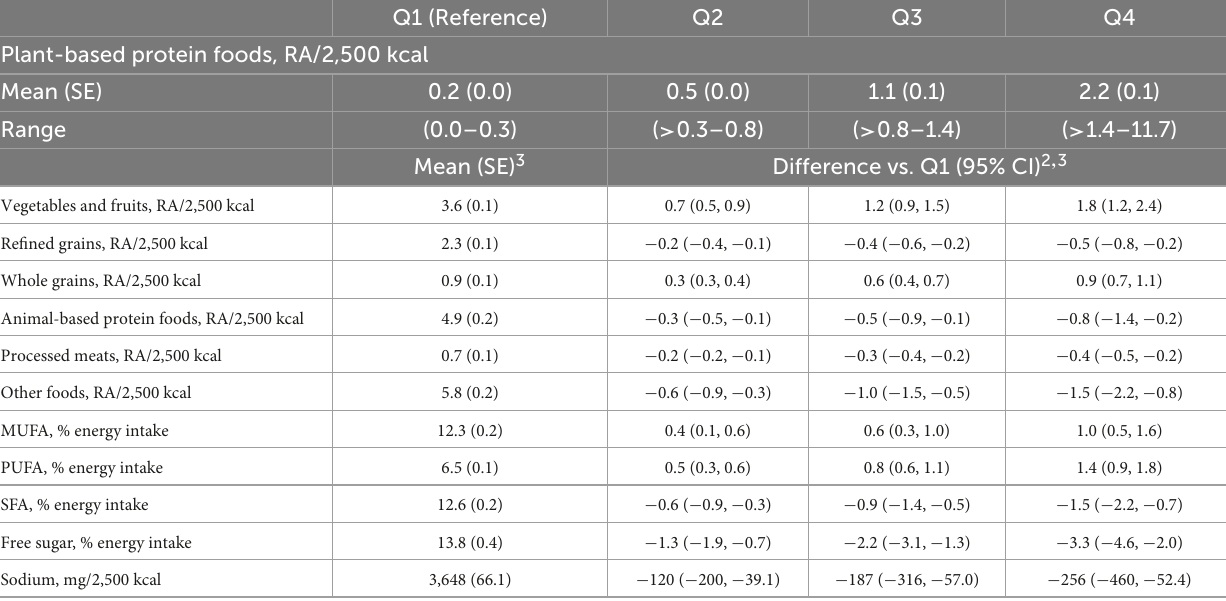
TABLE 5 Usual food and nutrient intakes across quarters of plant-based protein food intake in French-speaking adults from Québec, Canada 1 , 4 . Q1 (Reference) Q2 Q3 Q4